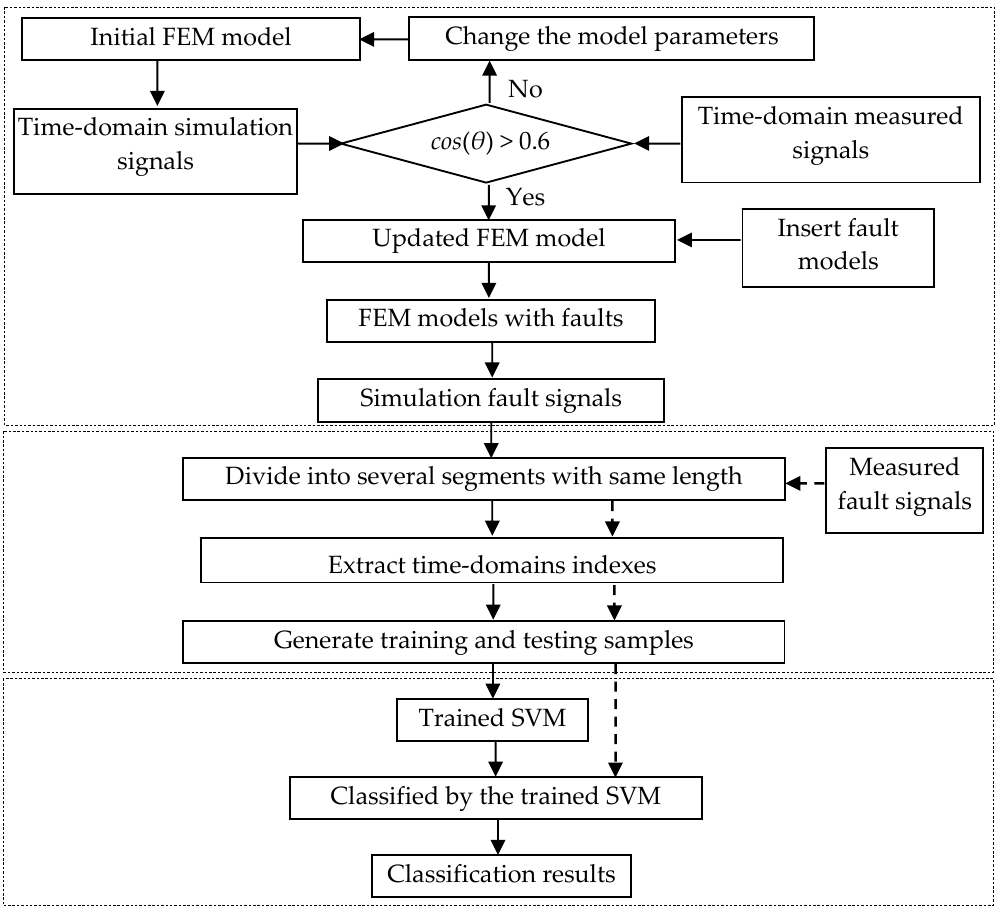
Figure 1. The flowchart of the personalized fault diagnosis method.